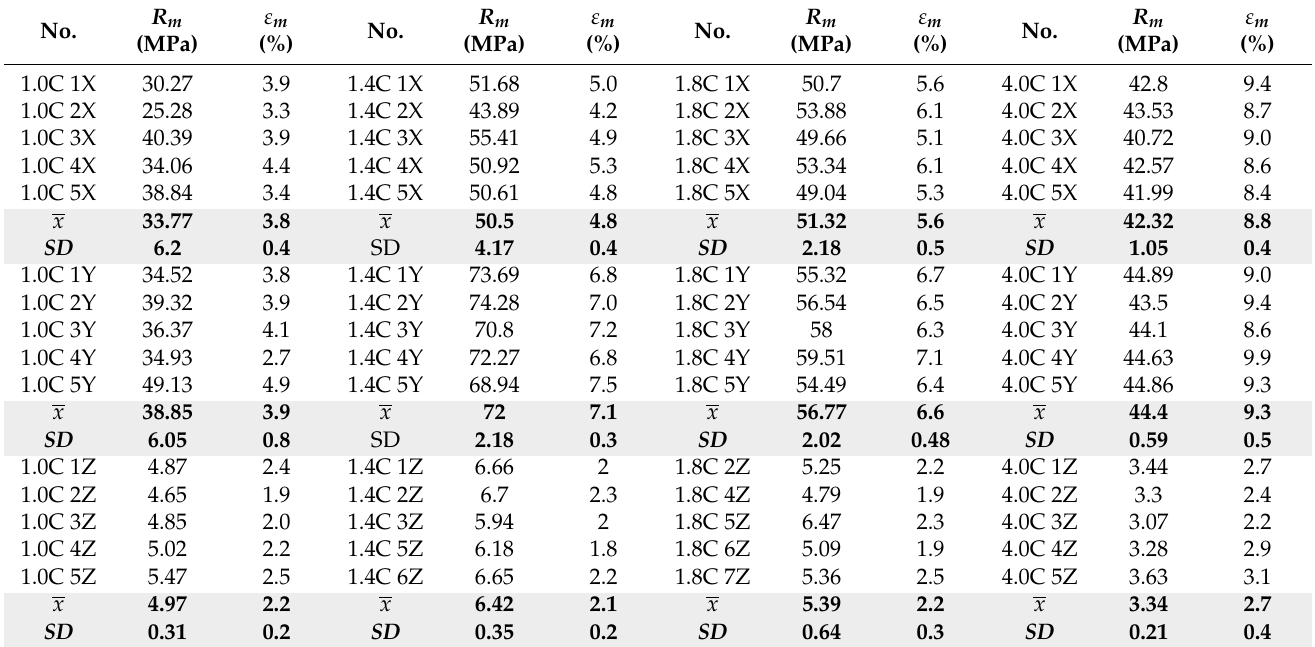
Table 5. Ultimate tensile strength and the maximum percentage deformation for the PLA